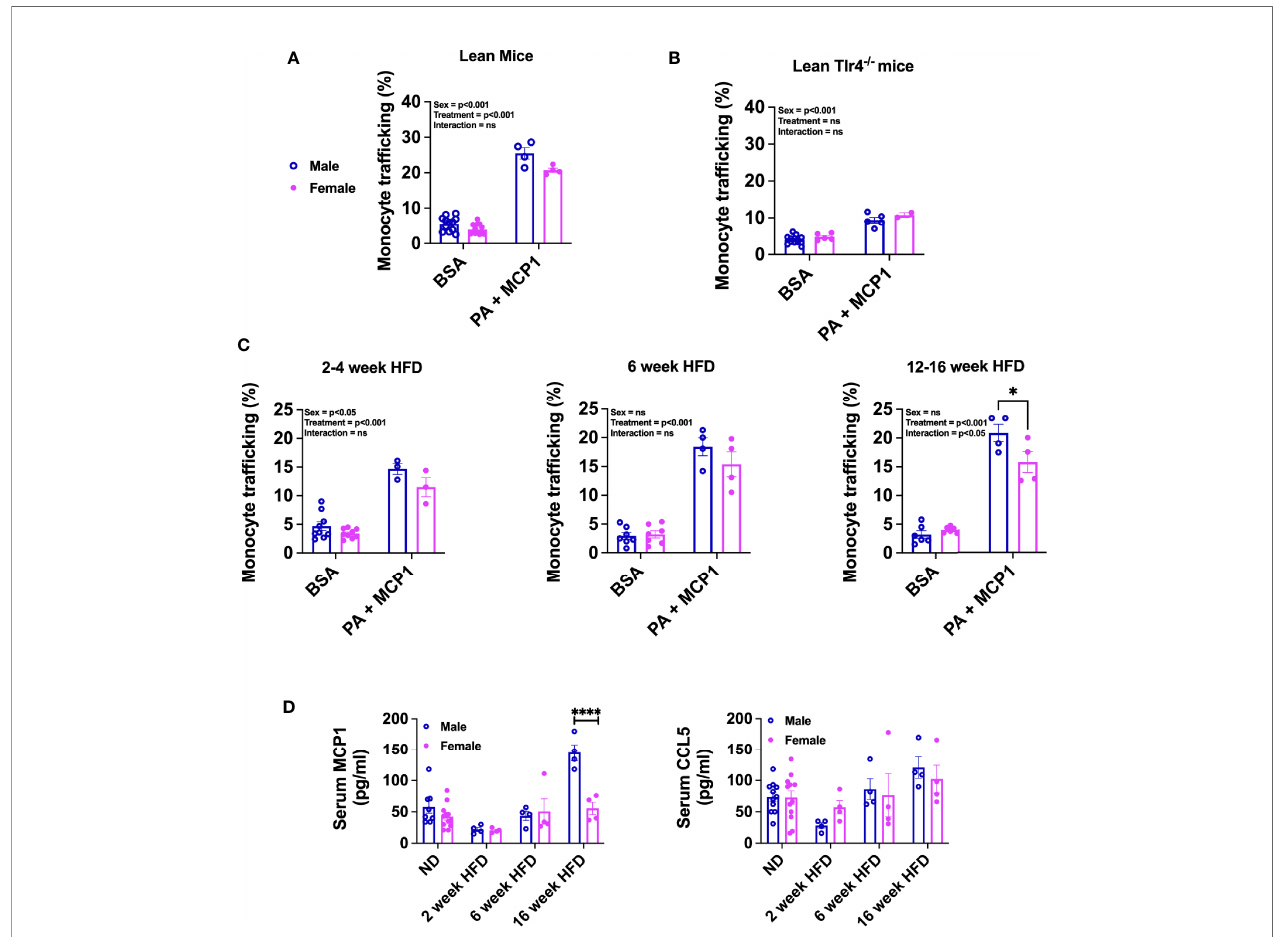
FIGURE 5 | Sex differences in migration ef fi ciency of monocytes with HFD. Monocyte traf fi cking (%) of BM monocytes from male and female (A) lean 22-week-old mice and (B) lean 22-week-old Tlr4 -/- mice. Monocytes stimulated with a combination of PA and MCP1 in (C) 2- to 4-week HFD mice, 6-week HFD mice, and 12- to 16-week HFD mice. N=4-6 mice per condition. Data were analyzed by 2-way ANOVA followed by Tukey ’ s multiple comparisons test. (D) Serum ELISA from ND, 2-, 6-, and 16-week HFD male and female of (D) MCP1 and CCL5. These data were analyzed by two-sample t-test. N = 12 for ND; 4 for HFD. Data shown as average +/- SEM. *p < 0.05, and ****p < 0.001. ns= non-signi fi